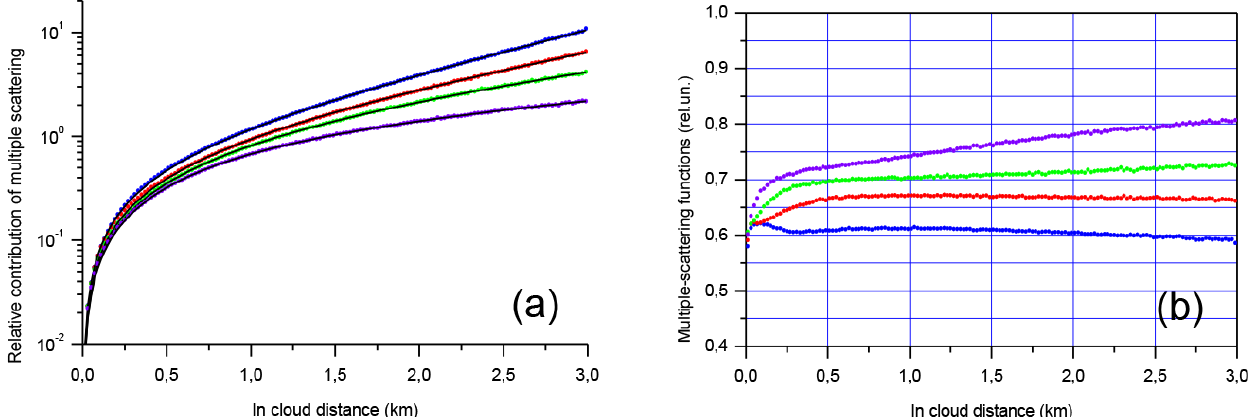
Figure 10. Multiple-scattering contributions R MSto1 to lidar signals (a) . Points – MC simulations, black lines – fitting with the empirical model. Multiple-scattering functions η MS (d) (b) . The RFOV is of 50mrad (blue points), 20mrad (red points), 10mrad (green points), and 5mrad (purple points). The distance to the cloud base is